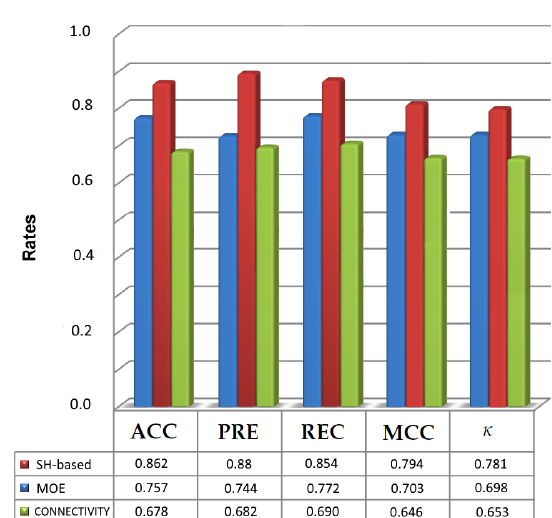
Figure 5. Maximum evaluation results obtained for the prediction of active molecules with spherical harmonic-based approach, MOE-type molecular descriptor and Connectivity descriptor using PCVM as the